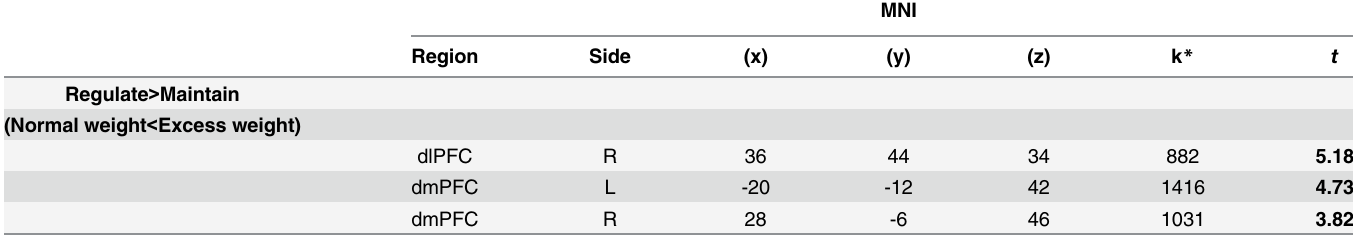
Table 4. PPI Results.